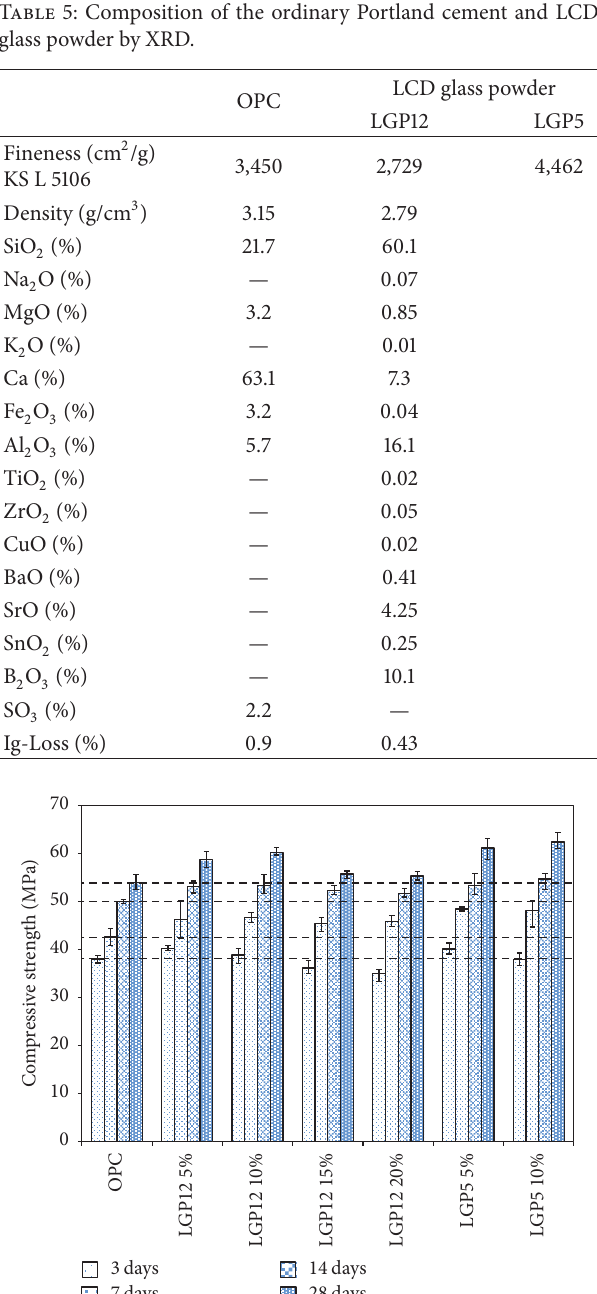
Figure 5: Comparison on each age strength development of LGP concrete cylinders.